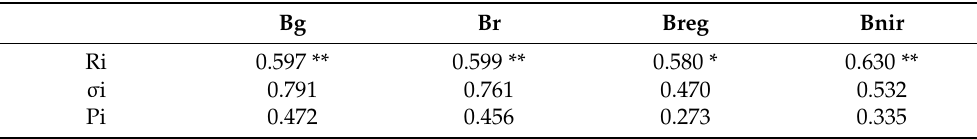
Table 6. Diagnostic index of each band in UAV imagery.